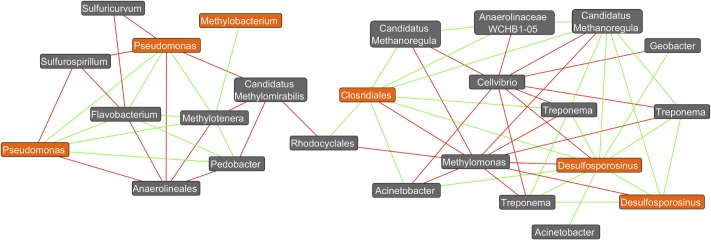
Co-occurrence network plot reveals strong positive and negative correlations (Spearman’s rho >0.9) between OTU abundances. A co-occurrence network generated from an unrarified OTU table containing bacterial abundance data from all 26 groundwater samples was created within the Cytoscape plugin Conet. All taxa unassigned at the kingdom taxonomic ranking are not shown. Only strong correlations (spearman’s rho >±0.9) were included in the network. Potential DCM-degrading taxonomy are highlighted in orange, with all remaining taxa highlighted in gray. Green edges connecting two nodes are indicative of a strong correlation (spearman’s rho >0.9) between the taxa, whereas red edges are indicative of a strong negative correlation (spearman’s rho < –0.9). It can be observed that 2 distinct clusters form at the right and left of the plot, with aerobic DCM degrading bacteria (Pseudomonas and Methylobacterium) identified in the left cluster, and potential anaerobic degraders (Desulfosporosinus and Clostridiales) on the right. Strong positive correlations can be observed between the potential DCM-degrader Desulfosporosinus and three unique Treponema OTUs in addition to Candidatus Methanoregula, Acinetobacter, Geobacter, and unclassified Clostridiales. Methylomonas and Cellvibrio were the only taxa calculated to have strong negative correlations (spearman’s rho <–0.9) with Desulfosporosinus. The unclassified Clostridiales taxon was also found to correlate strongly with Treponema, in addition to six other non DCM-degrading OTUs. Two unique OTUs assigned to the pseudomonas genus were found to have strong positive correlations with Flavobacterium, Pedobacter, and Methylotenera, and strong negative correlations with Sulfurospirillium, unclassified Anaerolineales, Candidatus Methylomirabilis and Sulfuricurvum. Potential DCM-degraders appear to correlate with specific bacteria not yet associated with DCM degradation, revealing possible degradation capacities or bacterial enrichment capabilities.